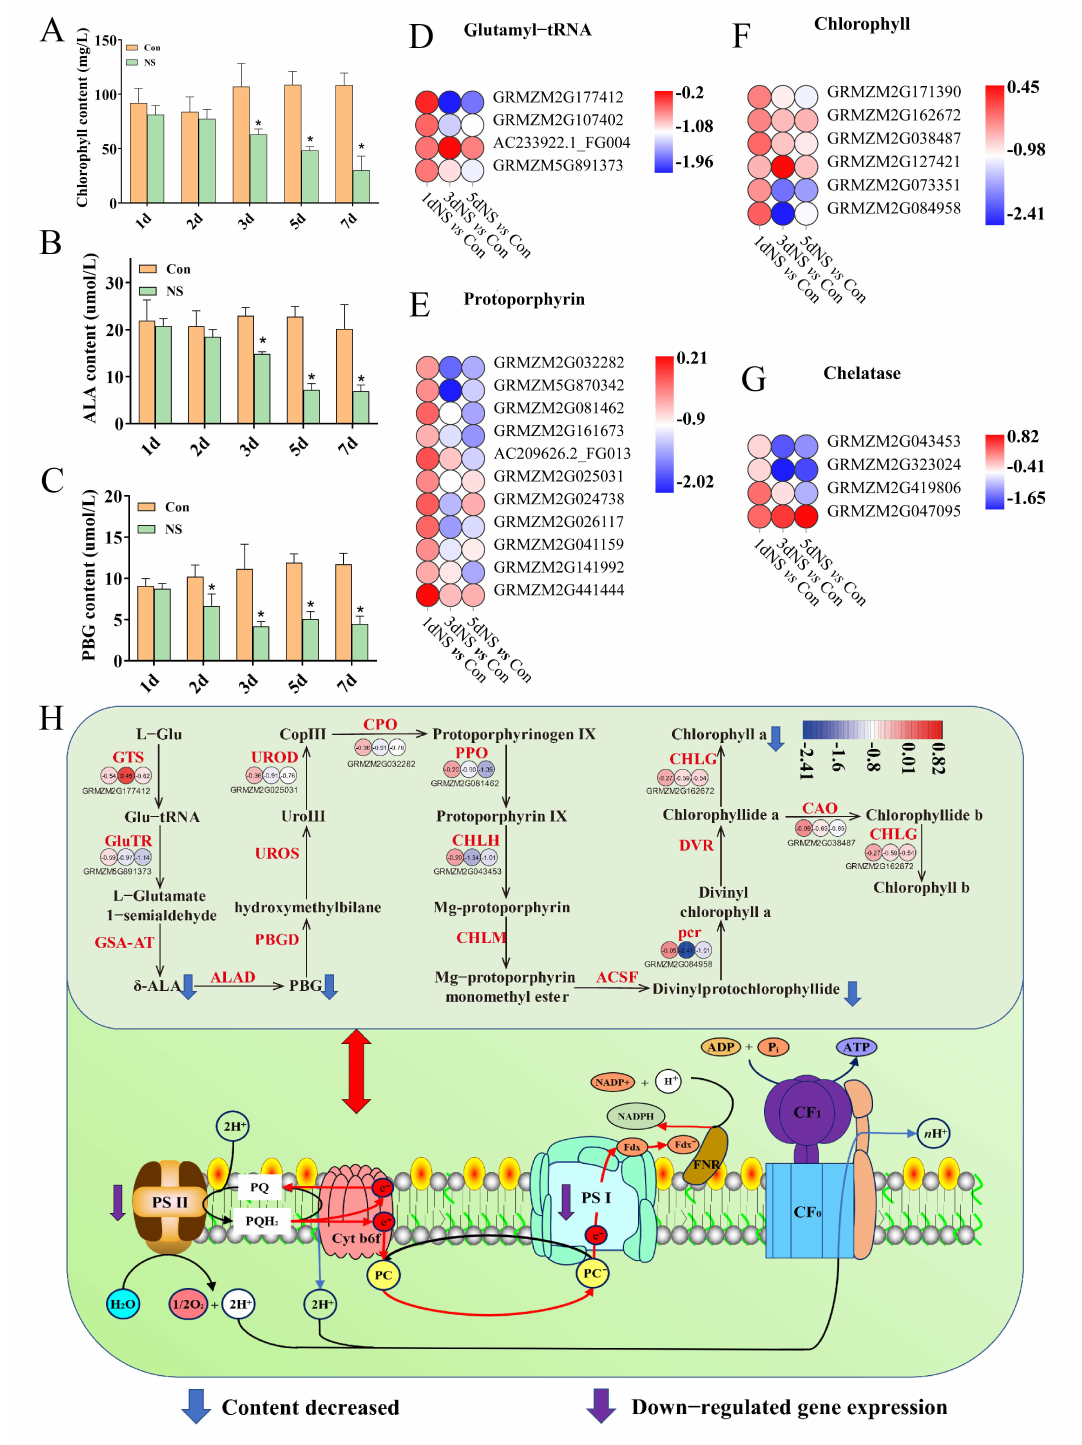
Figure 4. Changes in photosynthetic pigment synthesis in maize seedling leaves under phospholipase C inhibition. ( A ), chlorophyll content; ( B ), ALA content; ( C ), PBG content; ( D ), DEGs related to Glu-tRNA; ( E ), DEGs related to porphyrinogen; ( F ), DEGs related to chlorophyll; ( G ), DEGs related to chelatase; ( H ), chlorophyll synthesis pathway. The small circles represent the heat map of DEGs, and the numbers represent the fold change. Values are shown as mean ± SD ( n = 3 individuals per group). * means that the difference from the control reaches a significant level, p <